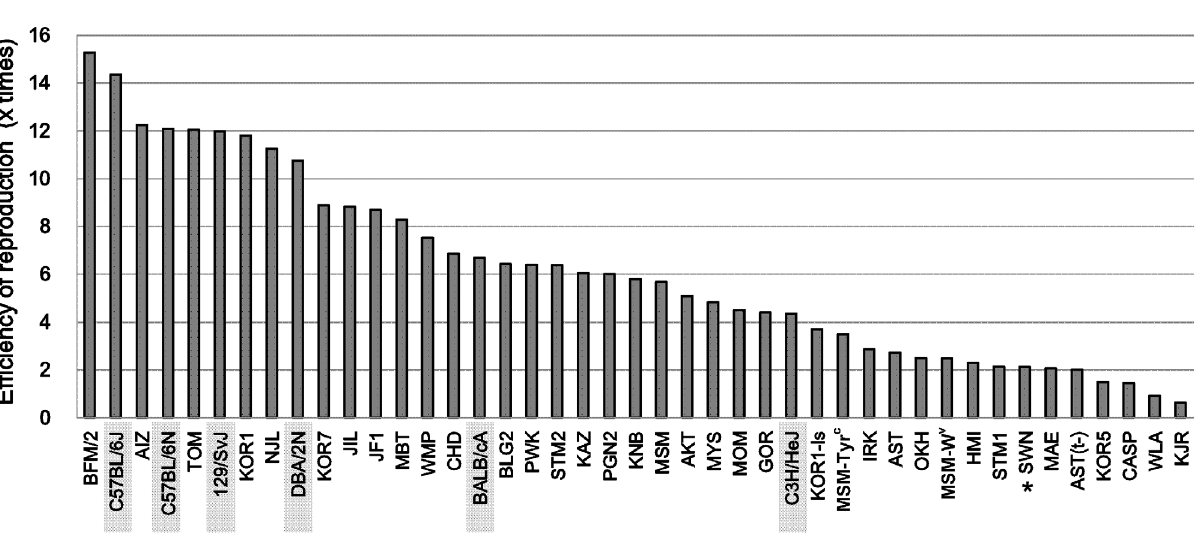
Figure 6. The overall reproduction efficiencies in wild-derived strains and standard inbred strains (shaded). The efficiencies were calculated as the number of offspring produced from one superovulated female; i.e., the multiplication of the averages of the number of collected oocytes per female by eCG or AIS treatment, the fertilization rates with fresh spermatozoa, the survival rates of embryos cryopreserved with HOV method, and the birthrates after embryo transfer by conventional or improved method. For the SWN strain, the birthrate data were obtained from embryos derived from natural mating (asterisk) (see Figure 5). For standard inbred strains, refer to Tables S7 and